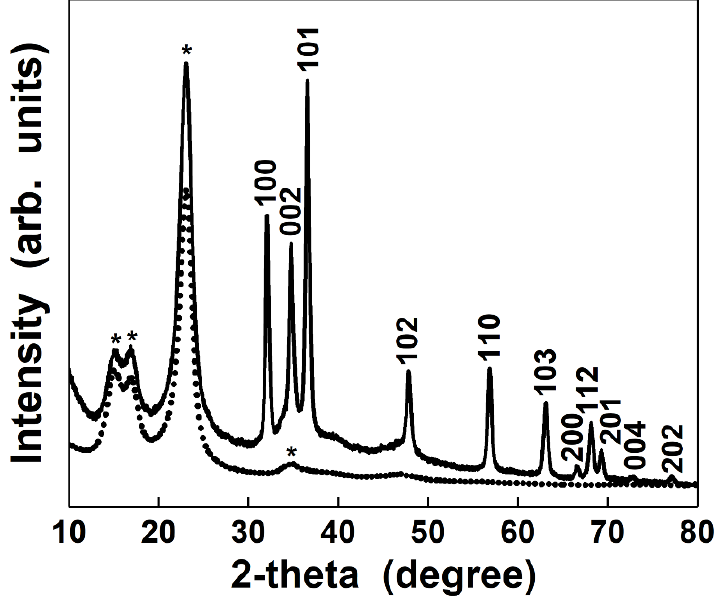
Figure 2. XRD patterns of flax (dotted curve) and ZnO-coated flax fibers (solid curve) as fabrics. * Peaks attributed only to flax fibers .